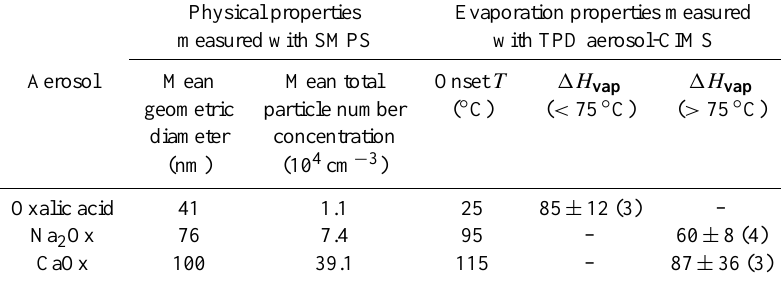
Table 1. Physical properties of the generated particle size distribution – mean geometric size and mean concentrations of the particles during the TPD aerosol-CIMS experiments are presented. Onset temperatures for evaporation and 1 H vap of oxalate at different temperature ranges; the number of data points used in the linear fits are in parentheses. Experiments were performed using oxalic acid aerosol, sodium oxalate Na 2 Ox and calcium oxalate